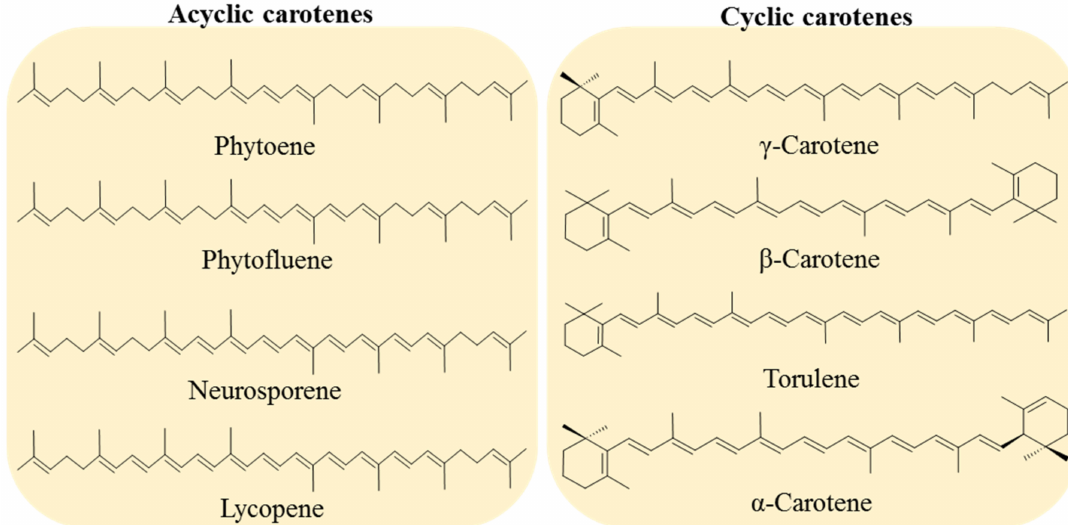
Figure 1. Examples of acyclic carotenes, all containing two linear ψ -end groups: phytoene, phytofluene, neurosporene, and lycopene. Cyclic carotenes with one or two β -rings ( γ -carotene, β -carotene and torulene) and one β - and one ε -rings ( α -carotene).